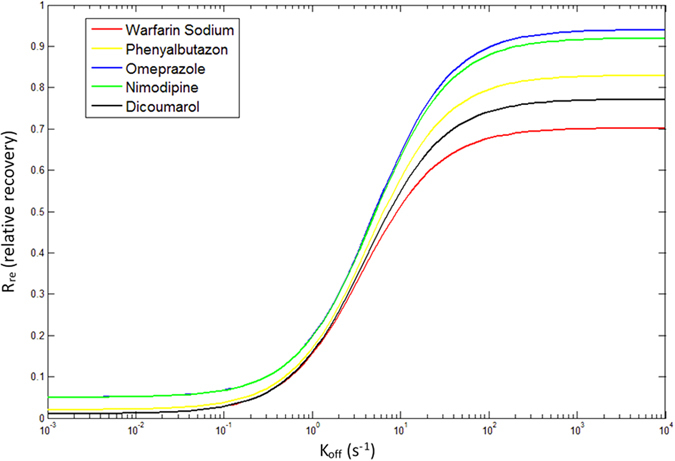
The relationship of Rre and koff of the drugs.